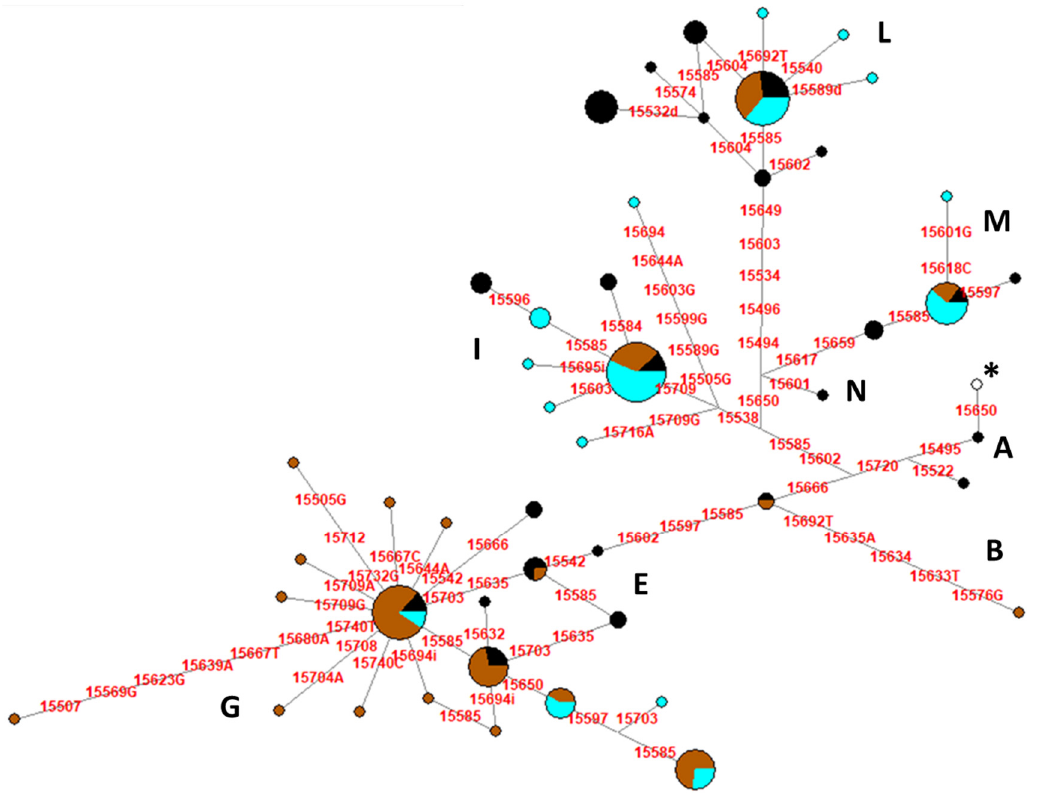
Figure 3. Median-Joining Network based on control-region sequences (nps 15,491–15,740) of Sardinian horse breeds. The asterisk indicates the haplotype identical to ERS. Three sequences not classified in mitochondrial DNA (mtDNA) haplogroups (JF804119, JF804147, and JF804151) were excluded from the analysis. Circles represent the haplotypes and are proportional to the observed frequency in 175 Sardinian horses (Table S2). Capital letters refer to mtDNA haplogroups, while colors indicate the different breeds: Giara (brown), Sarcidano (light blue), and Sardinian Anglo-Arab (black).